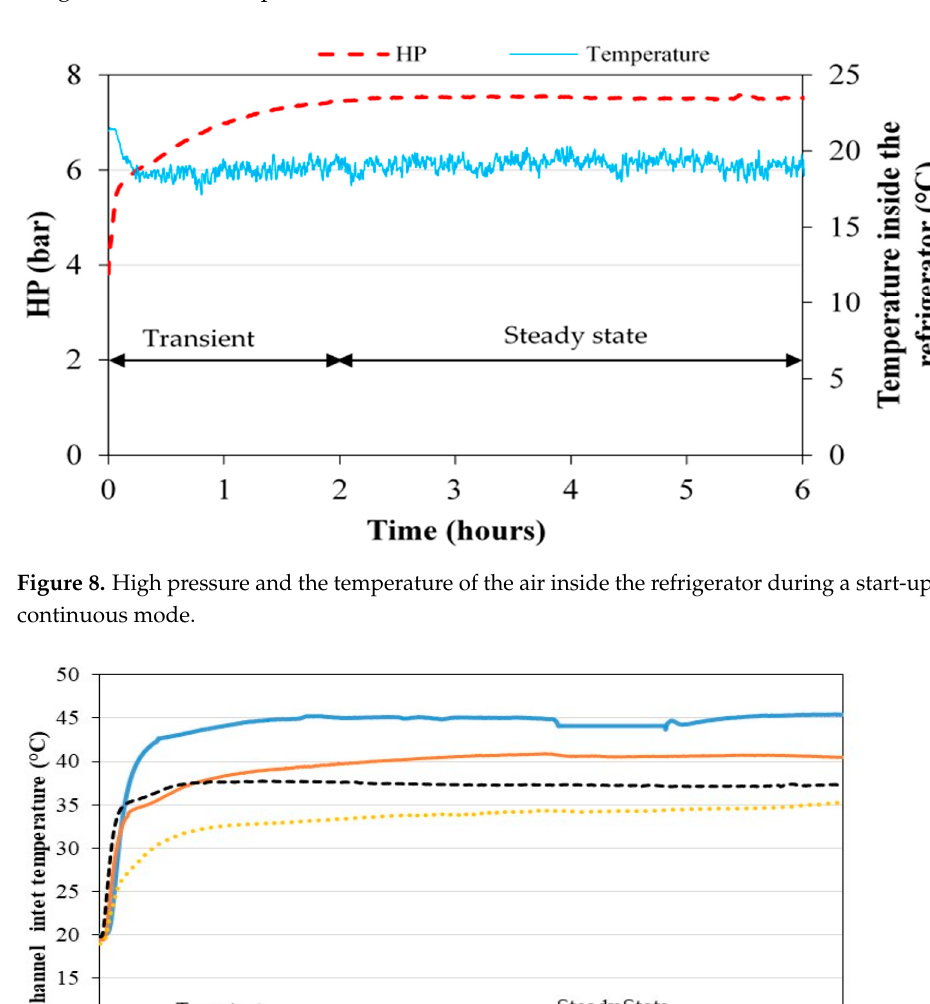
Figure 8. High pressure and the temperature of the air inside the refrigerator during a start-up test in continuous mode.